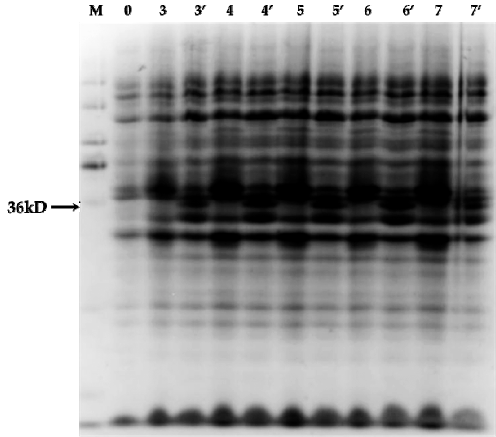
Figure 5. Expression of His-PnbHLH1 proteins. M: Marker ruler (120, 100, 80, 60, 50, 40, 30, 20, 12 kD); 0: total proteins of pET-28a-PnbHLH1 before induction; 3, 4, 5, 6, and 7: total proteins of pET-28a-PnbHLH1 were induced at 3, 4, 5, 6, and 7 h without IPTG respectively; 3’, 4’, 5’, 6’, and 7’: total proteins of pET-28a-PnbHLH1 were induced at 3, 4, 5, 6, and 7 h by IPTG, respectively.